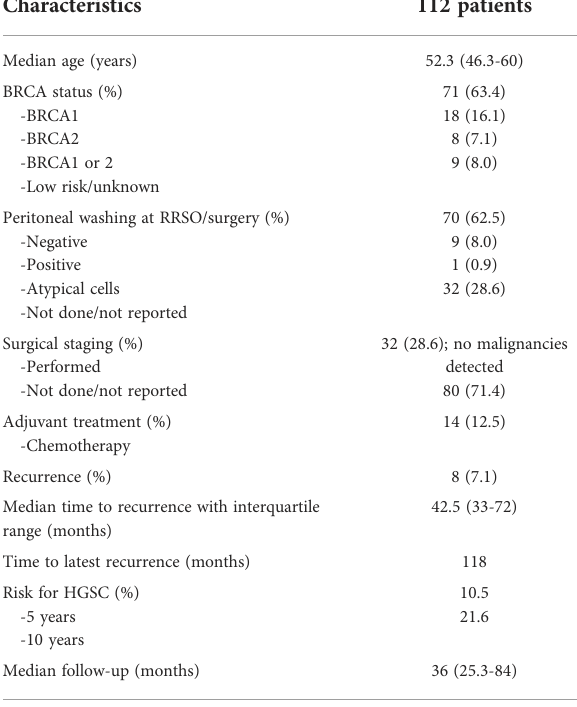
TABLE 3 Overview of the 112 included STIC patients.